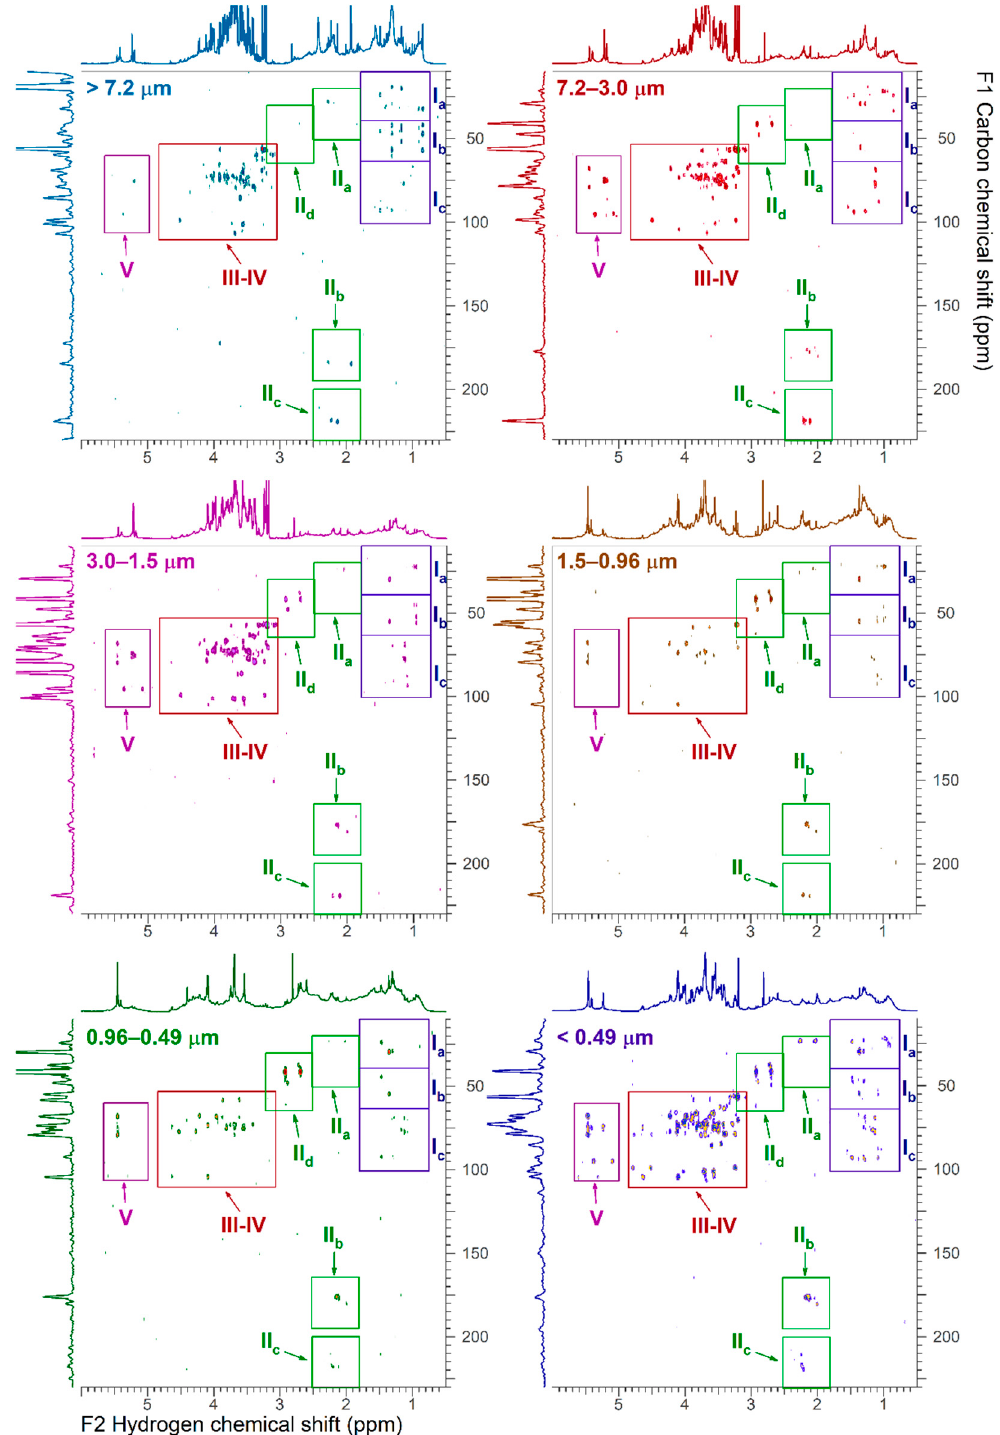
Figure 7. 1 H- 13 C HMBC NMR spectra of size fractionated particulate water-soluble organic carbon. The region III-IV and V are showed in detail in Figure S7. The x-axis F2 represents the hydrogen frequencies (in ppm) and the y-axis F1 represents the carbon frequencies (in ppm).